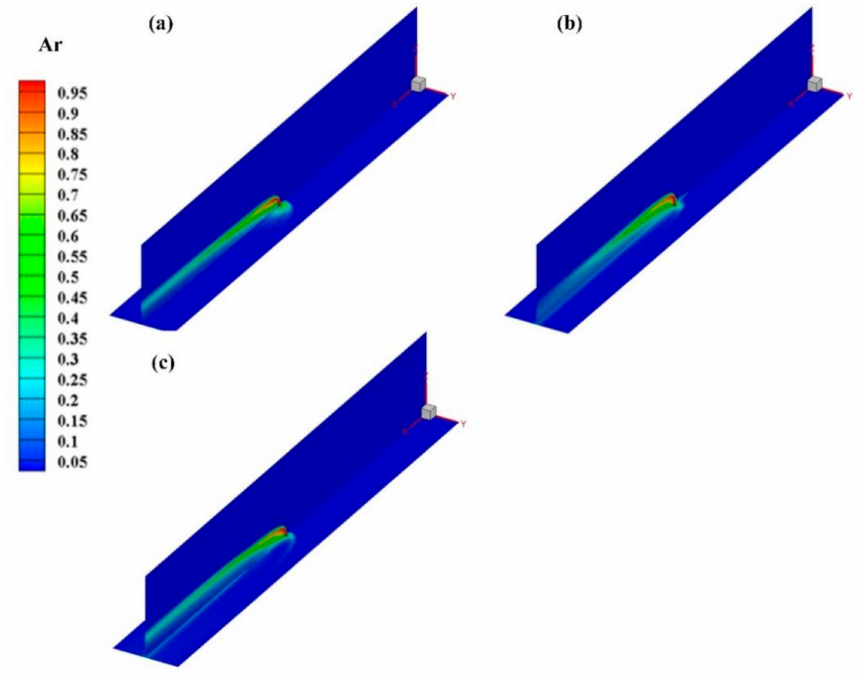
Figure 7. Mass fraction contour diagrams of argon for ( a ) Case a, ( b ) Case b, and ( c ) Case c at z = 0 mm and y = 0